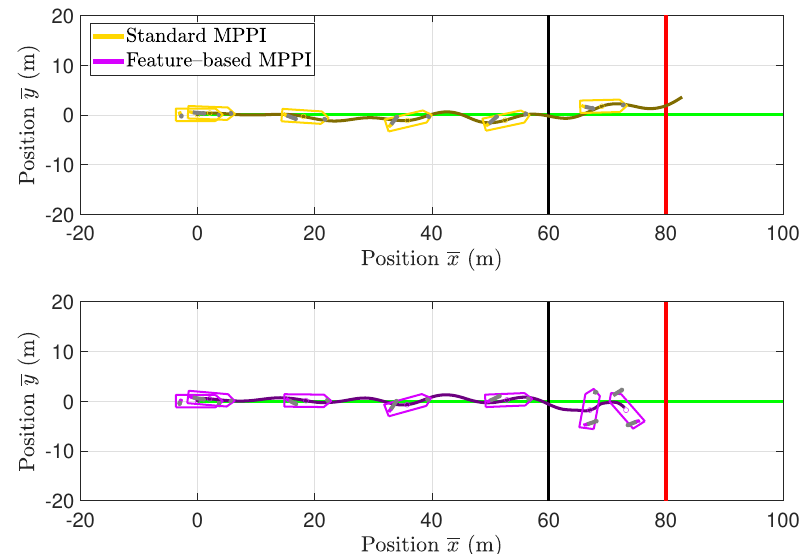
Figure 9. Comparison of the resulting trajectories of the vessel in full–scale experiments at Rhine river in Constance. Both plots use transformed coordinates calculated by (30). The green lines visualize the reference trajectories in both plots. After passing the black line, the vessel detects the obstacle visualized as a red line.